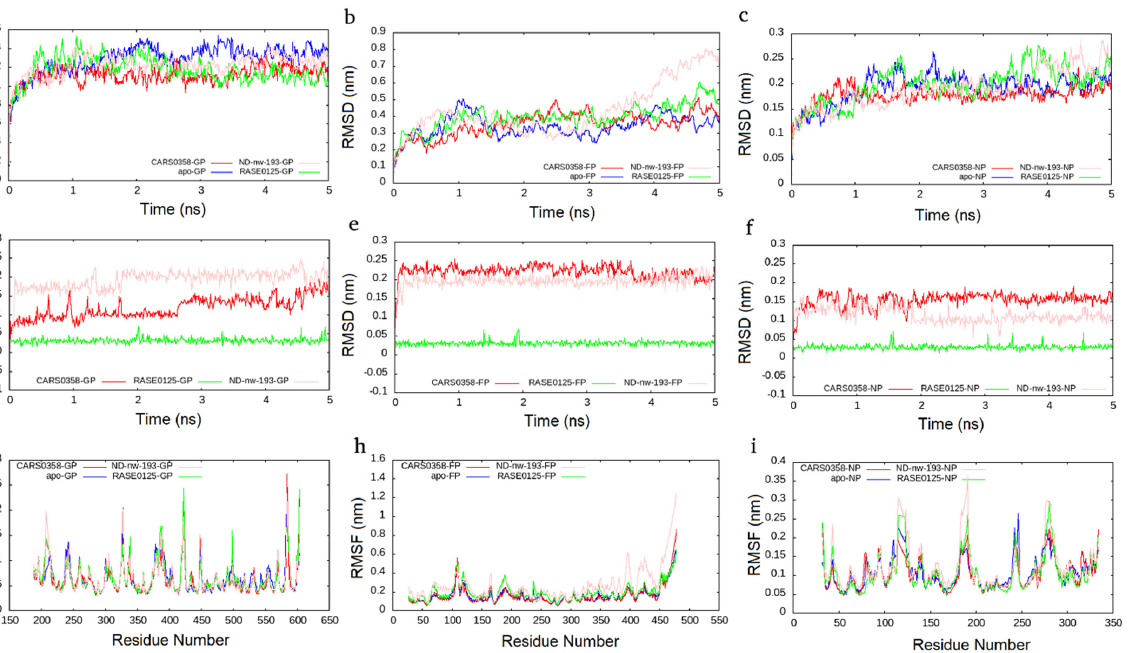
Figure 5. C α− RMSD plots for selected molecules (CARS0358 (red); RASE0125 (green), ND_nw_193 (pink)), complexed with NiV − G ( a ), NiV-F ( b ) and NiV-N ( c ). C α -RMSD plots for free proteins (blue) are also presented. RMSD plots for individual molecules in NiV − G ( d ), NiV − F ( e ), and NiV − N ( f ). C α− RMSF plot for NiV − G ( g ), NiV − F ( h ), and NiV − N ( i ) as a function of time .